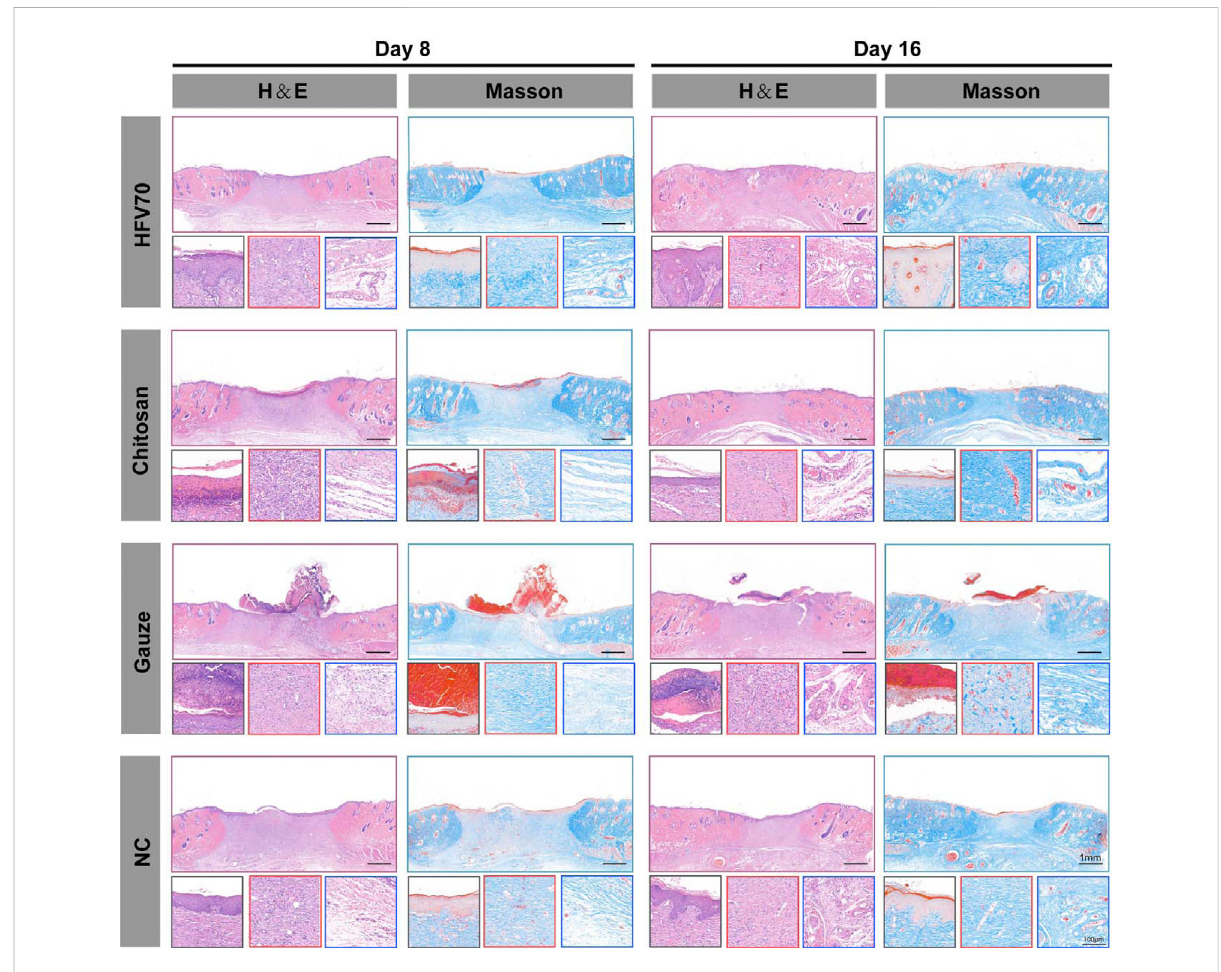
FIGURE 7 H&E and Masson ’ s staining images of wound areas in each group and detailed images corresponding to the epidermis (black square border), dermis (red square border), and subdermal tissues (blue square